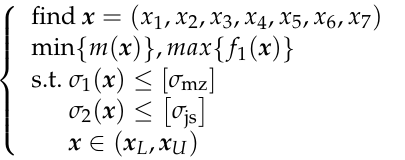
Figure 9. Surrogate model accuracy validation results: ( a ) Mass; ( b ) First-order natural frequency.